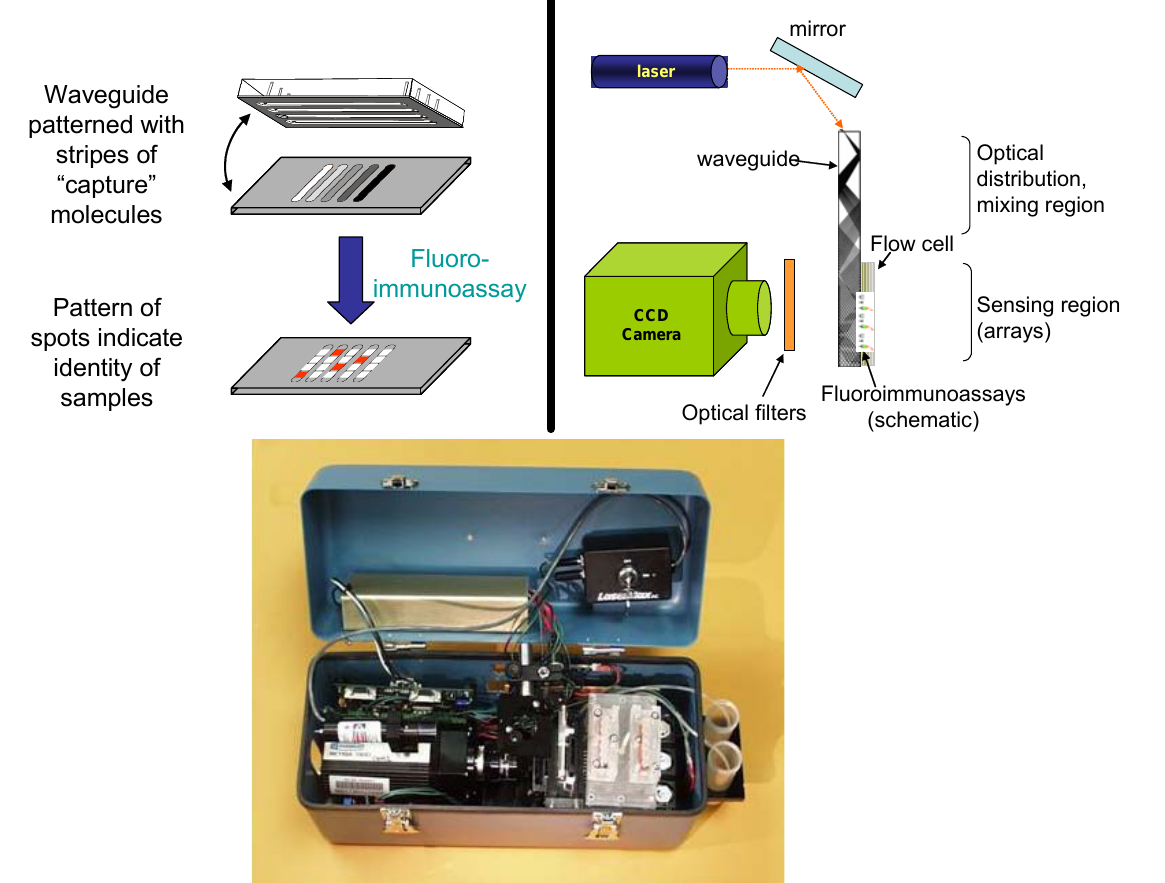
Figure 1 . The NRL Array Biosensor. Upper left: Physically-isolated patterning and sample analysis leads to formation of an array of fluorescent spots on the waveguide surface. Upper right: Optical configuration of the light source, waveguide, and CCD camera. Lower panel: Automated prototype of the NRL Array Biosensor. Imaging components of the system are found on the left side of the box, whereas components for fluid handling are found on the right side of the box. Segregation of the fluidics from the expensive electronic components ensures that damage from any potential leakage is minimal. The entire system weighs less than 7